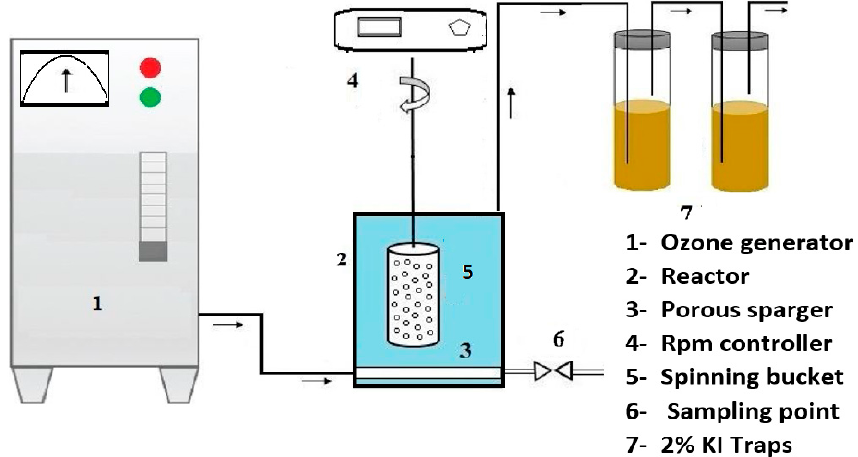
Figure 16. Experimental